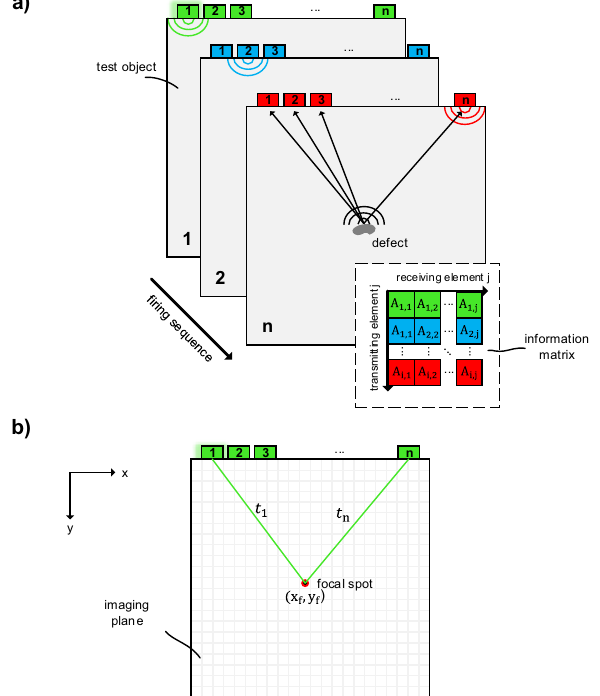
Fig. 1 In a data acquisition procedure for FMC together with the resulting information matrix and in b illustration of the TFM. The figure was adapted from